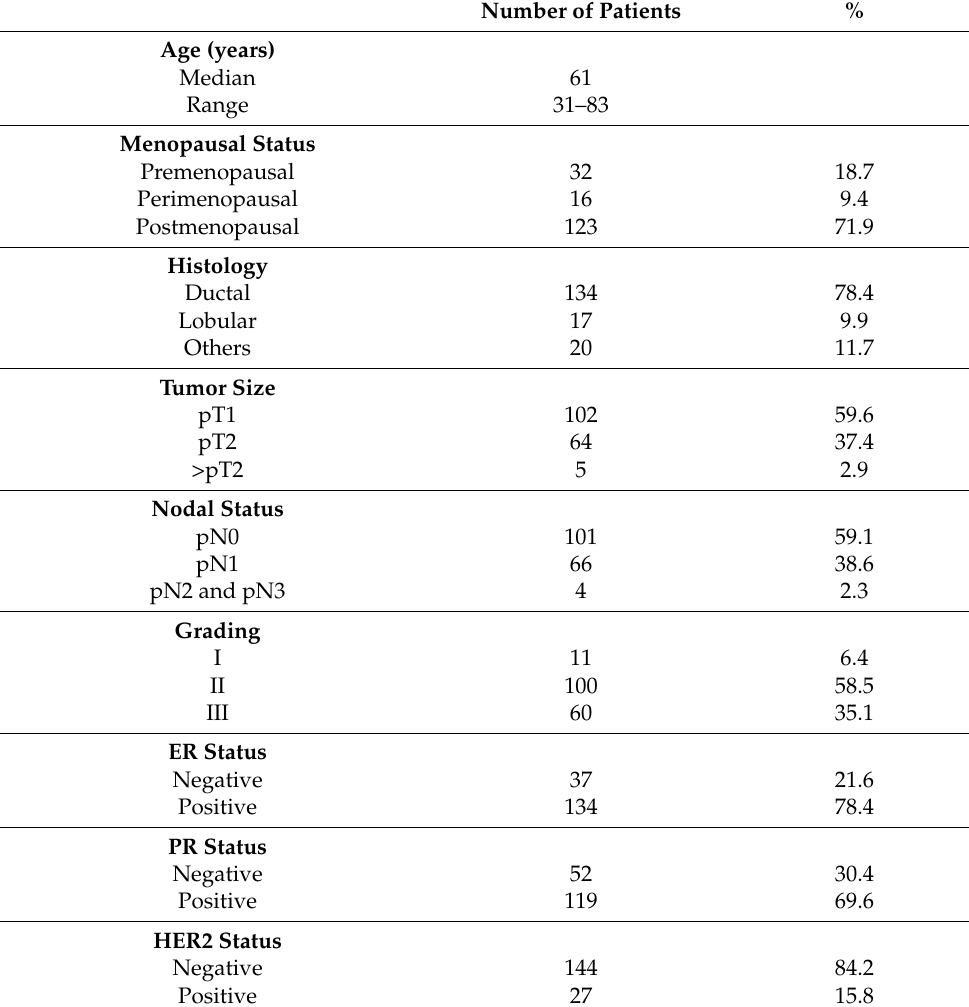
Table 1. Patients characteristics at the time of first